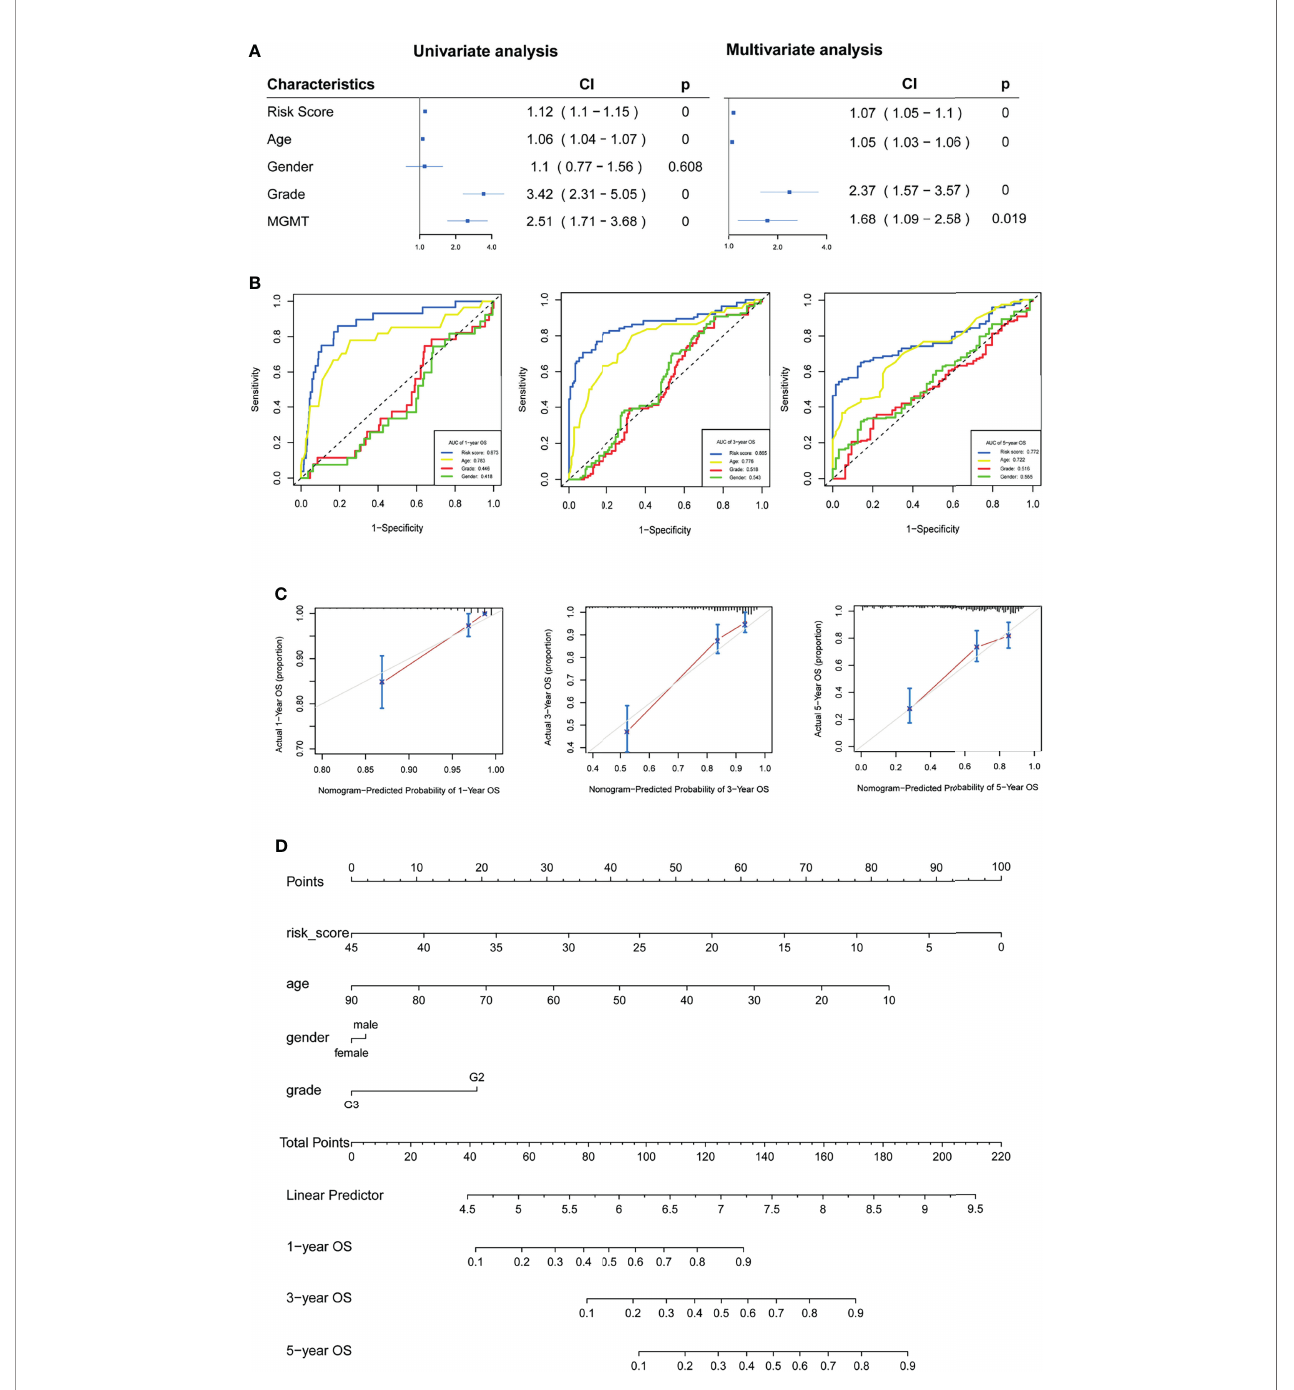
FIGURE 5 | Veri fi cation of the m5C LPS and construction of the nomogram. (A) Forest plots showingthe results ofunivariate andmultivariate Cox regression analyses on the prognosticperformance of the risk score and clinicopathological features. (B) ROC curves showing prediction performance ofthe riskscore and clinicopathological features. (C) Calibration curveof the nomogram for 1,3,5-year OS. (D) Construction of the nomogram using risk score and clinicopathological